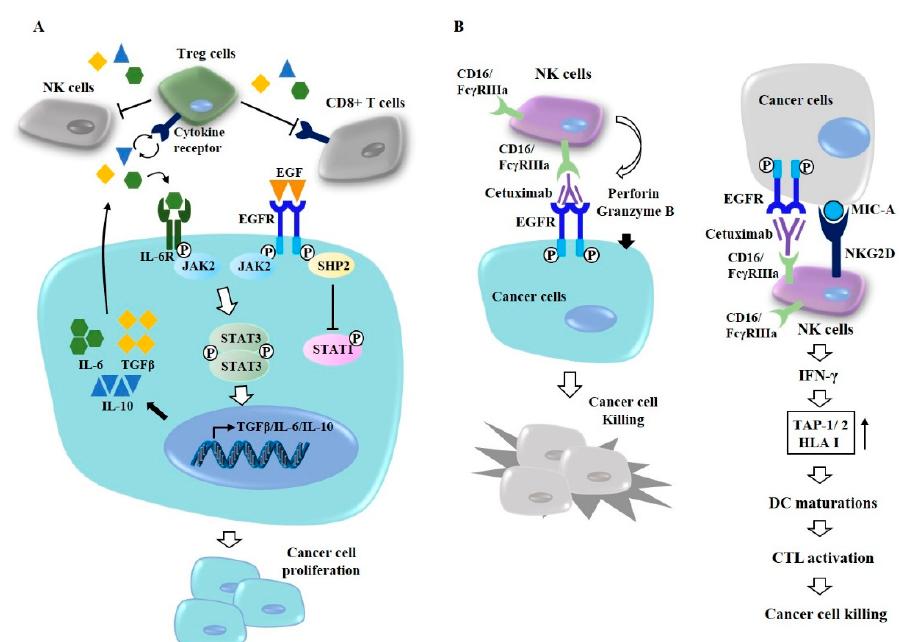
Figure 5. Antibody-dependent cell-mediated cytotoxicity mediates cytotoxic effect of cetuximab. ( A ) Upon binding of EGF, EGFR activates JAK2, which in turn leads to the activation of STAT3. STAT3 increases expression of immune suppressive cytokines, such as IL-6, IL-10, and TGF- β . IL-6, in autocrine fashion, binds to and activates IL-6 receptor. This binding activates STAT3. EGFR signaling activates regulatory T cells (Treg cells). Activated Treg cells suppress cytotoxic effects of natural killer cells (NK cells) and CD8+ T cells. IL-10 and TGF- β can also activate Treg cells. ( B ) Cetuximab-activated NK cells display cytotoxic effects against cancer cells by perforin and granzyme B (left). Cetuximab-activated NK cells interact with cancer cells through natural killer group 2 member D (NKG2D)- MHC class I chain-related gene A (MIC-A) binding. This interaction induces dendritic cell (DC) maturation by increasing expression levels of transporter 1 ATP-binding cassette sub-family B(TAP-1)/ transporter 2 ATP-binding cassette sub-family B (TAP-2) and human leukocyte antigen I (HLA I) via interferon (IFN)- γ . DC maturation enhances cytolytic T lymphocytic activity towards cancer cells (right). Cetuximab, a murine–human chimeric antibody, can bind to the extracellular domain of EGF receptor [89] (Figure 5B). Combined inhibition of EGFR and JNK / MAPK can overcome resistance to cetuximab [90]. Natural killer (NK) cells can interact with cancer cells through Fc γ RIIIa (CD16) which binds to cetuximab (Figure 5B). Cetuximab-activated NK cells display a cytotoxic e ff ect toward cancer cells by perforin and granzyme (Figure 5B, left). NK cells activated by cetuximab display cytotoxic e ff ects toward NSCLC and osteosarcoma [91,92]. Imgatuzumab, a novel glycoengineered